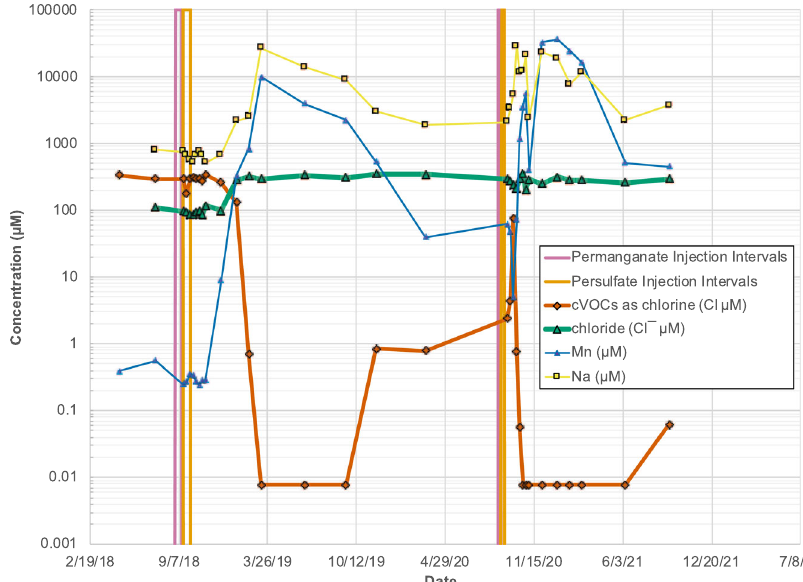
Fig. 3 Concentrations of cVOCs as chlorine, chloride, and oxidants in well WSM001CC showing cVOCs are depleted when oxidants arrive. Reddish purple and orange lines indicate beginning and end of permanganate and persulfate solution injections, respectively. Vermillion line with vermillion diamonds mark concentrations of cVOCs as chlorine, which is depleted soon after high concentrations of oxidants arrive. Bluish green line with large bluish green triangles mark chloride concentrations, which increases as cVOCs are destroyed by oxidants. Blue line with small blue triangles mark concentration of manganese, which is directly related to permanganate concentration. Yellow line with yellow squares mark concentrations of sodium, which is directly related to persulfate concentration. Only two dates (9/25/18 and 6/9/21) were analyzed in duplicate for chloride and the data ranges are too small to see in this fi gure (range 4 µ M).